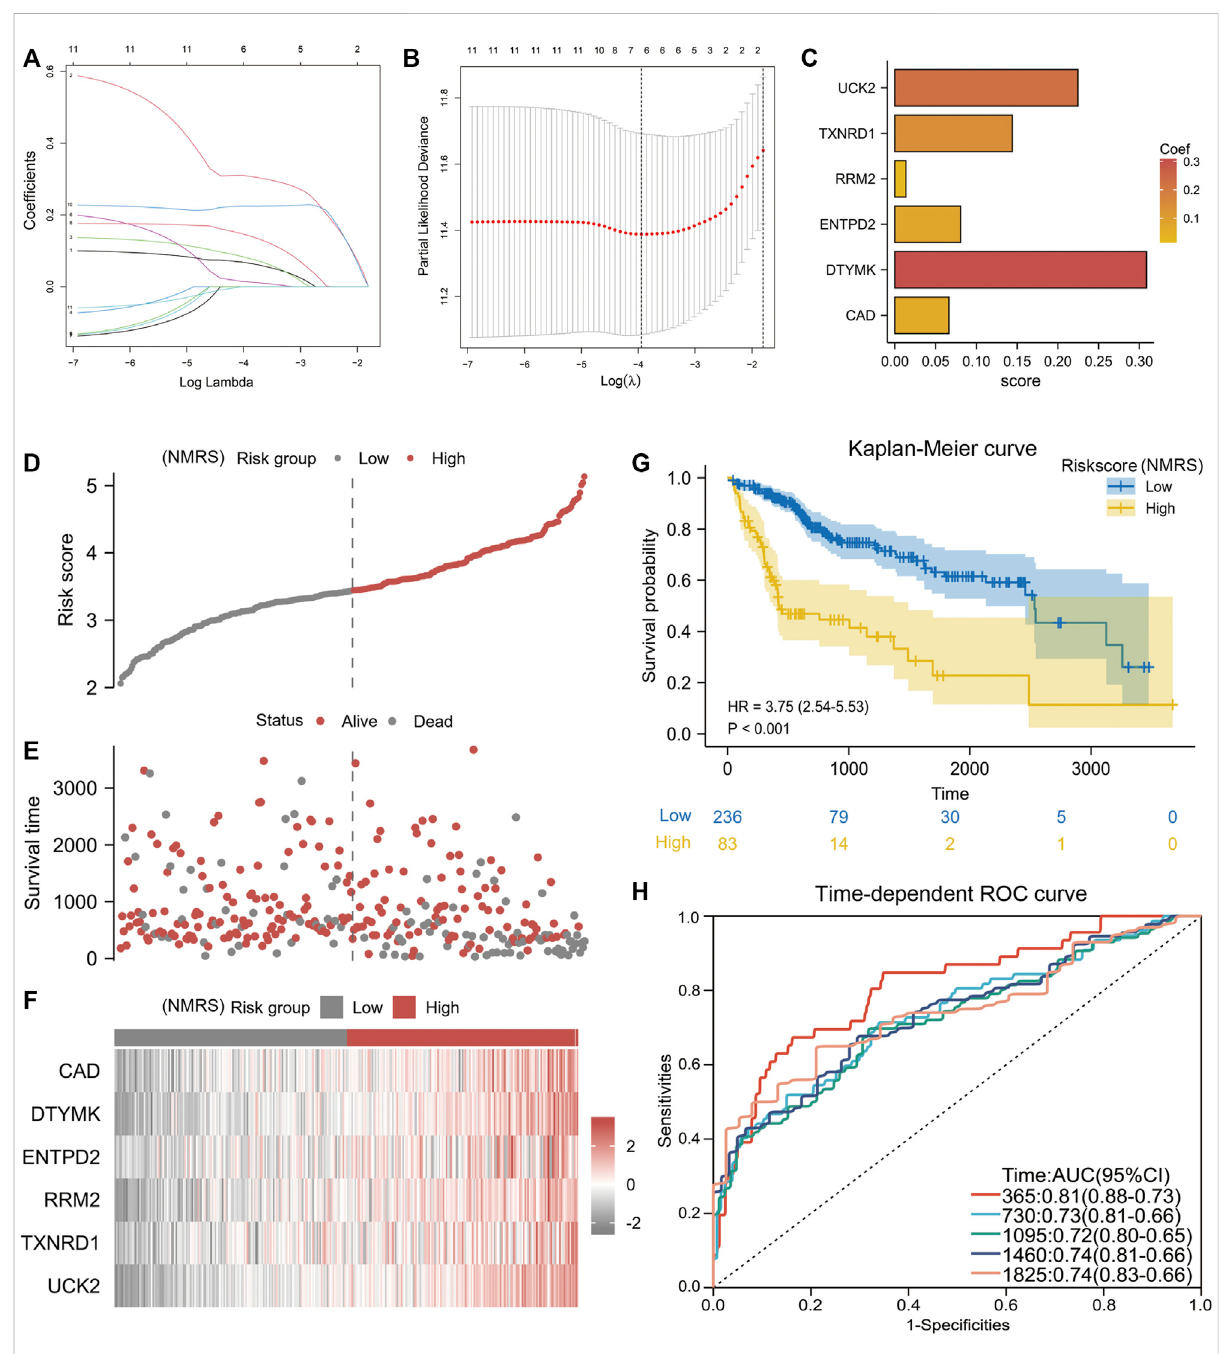
FIGURE 2 Construction of NMRS. (A) Lasso-Cox regression analysis of eleven nucleotide metabolism-related genes. (B) Ten-fold cross-validation. (C) Six model genes with non-zero coef fi cients were obtained after screening. (D) NMRS were calculated for each hepatocellular carcinoma patient based on the formula, and patients were divided into high and low NMRS groups by median. (E) Correlation of NMRS with survival status. (F) Differences in theexpressionofsixbiomarkergenesbetweenthehighandlowNMRSgroups. (G) Prognosticdifferencesbetweenpatientsinthehighandlow NMRS groups. (H) Time-dependent ROC curves to validate the predictive accuracy of the prognostic